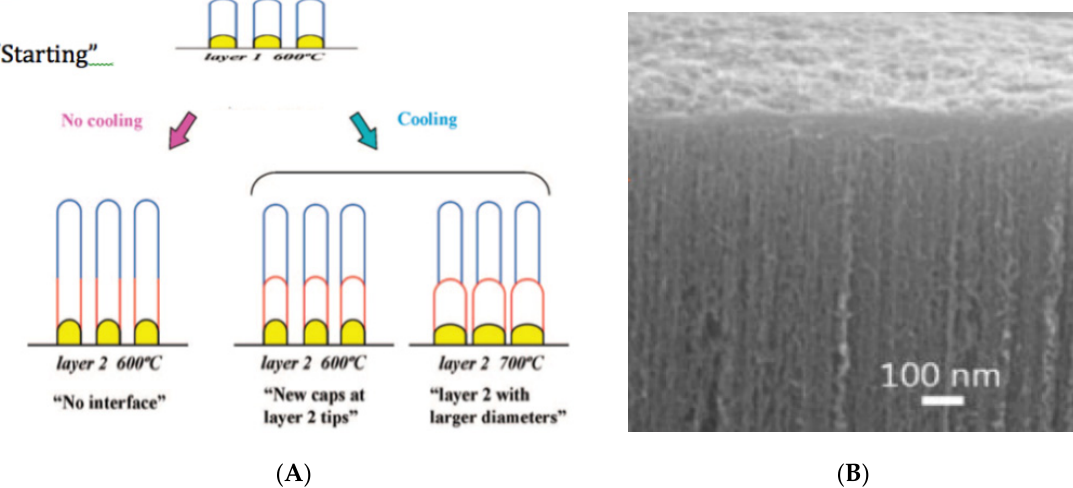
Figure 5. ( A ) Growth of CNT forests. Reprinted from Iwasaki et al. [18] with permission from ACS. ( B ) Closed Packed CNT Forests. Reprinted from Robertson et al. [26] with permission from Wiley.